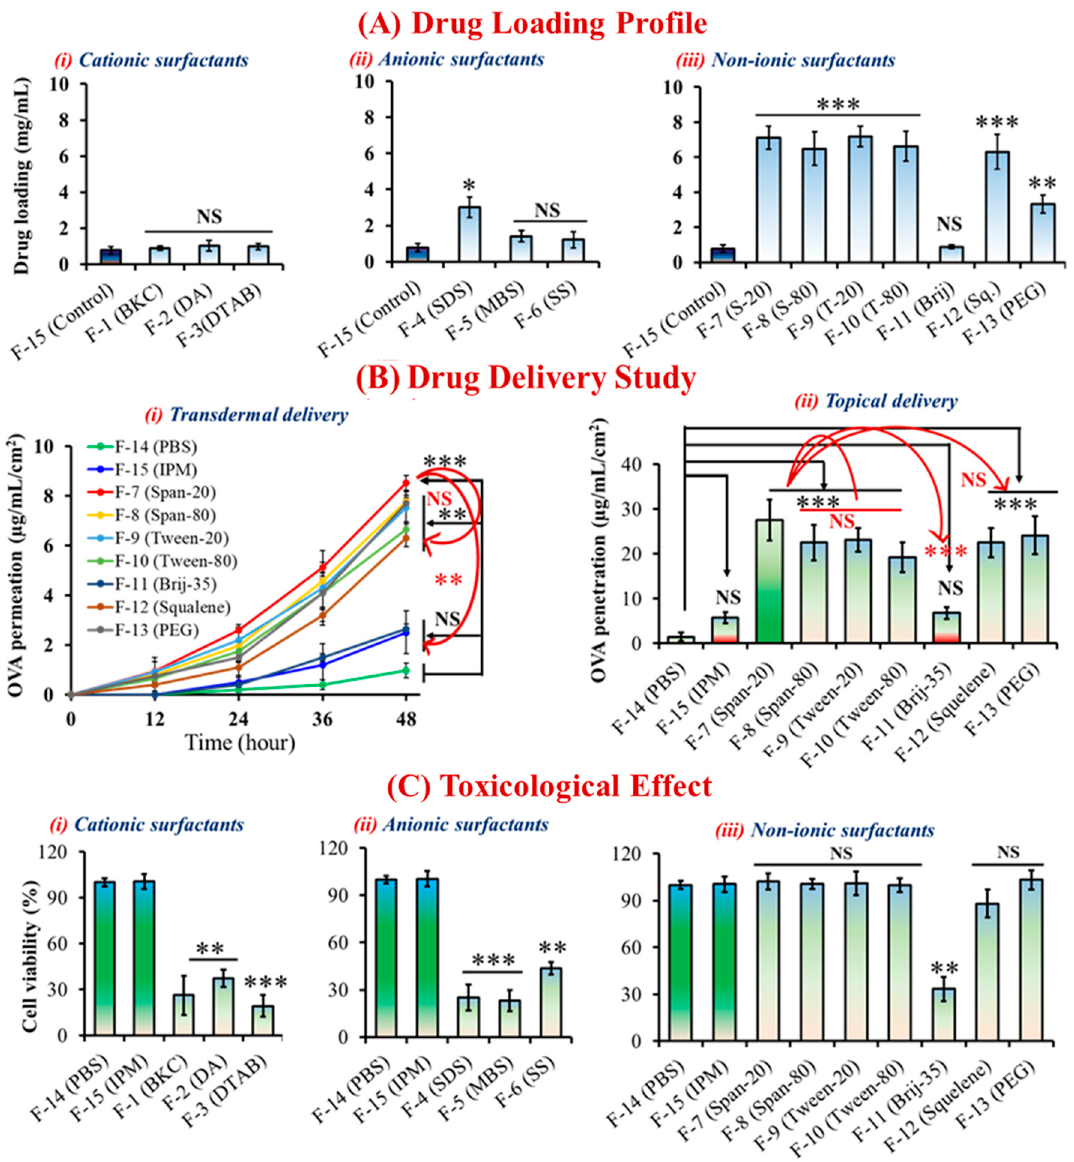
Figure 2. ( A ) Drug encapsulation capabilities of ILNDFs. ( B ) Transdermal and topical drug delivery of ILNDFs. ( C ) Cellular toxicity of ILNDFs. Data are presented as the mean ± SD (n = 3) * p < 0.1, ** p < 0.01, *** p < 0.001, and NS = not signi fi cant.